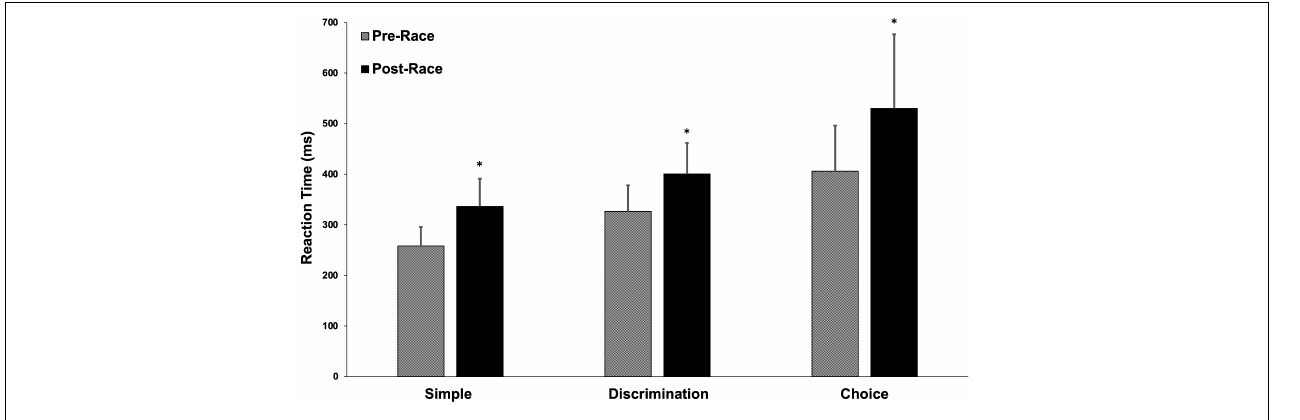
FIGURE 1 | Pre- and post-race reaction time. Values are displayed as a mean ( ± SD). ∗ p < 0.0001. TABLE 4 | Correlation matrix: pre-race associations between indices of cardiovascular function and cognitive performance and displayed as Pearson correlation coefficient. Variable Cardiovascular measure Cognitive